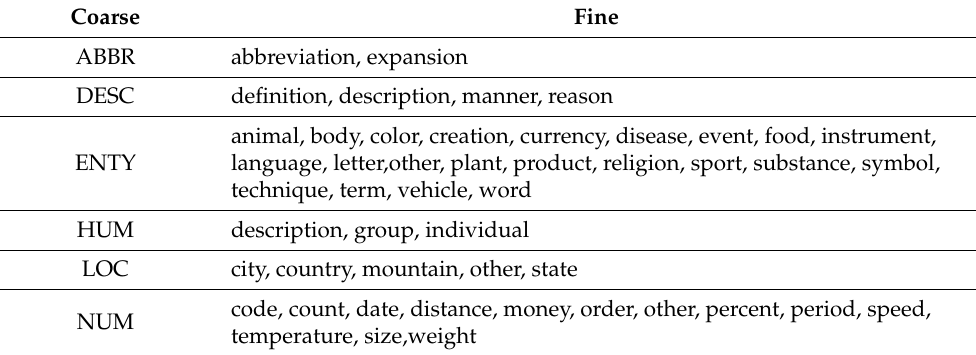
Table 1. UIUC classification standards.